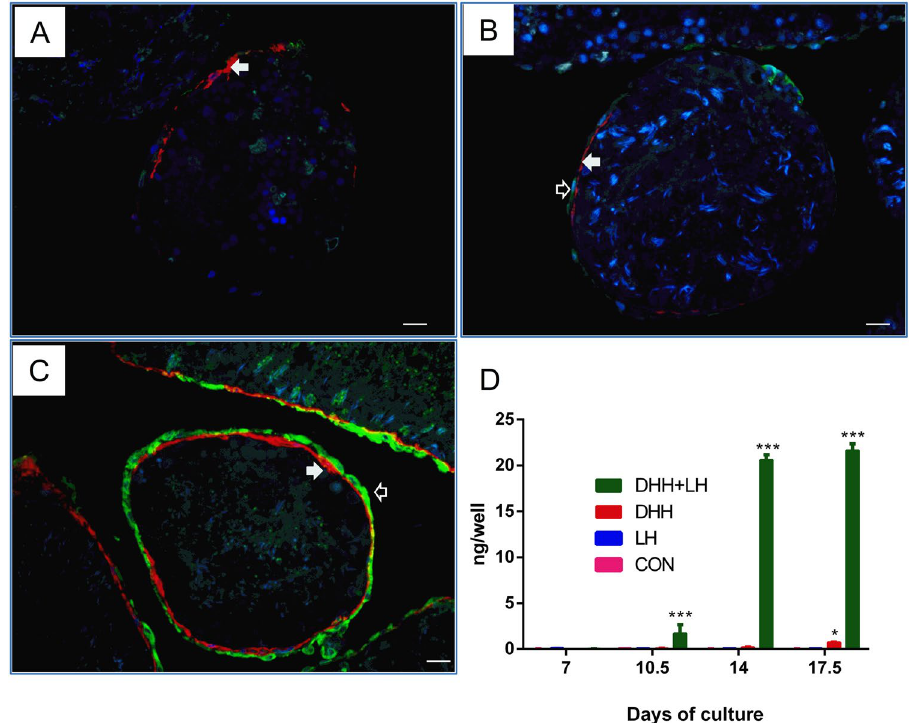
Figure 6. Differentiation of Leydig cells using an in vitro culture system of rat seminiferous tubules. 11 β - HSD1 staining (green color, unfilled arrow) showed the formation of Leydig cells at the advanced stages. α -Smooth muscle actin staining (red color, solid arrow) showed the myoid cells, which circle the seminiferous tubules. 11 β -HSD1 positive cells are outside the α -smooth muscle actin positive cells, indicating that they were differentiated from the stem Leydig cells on the surface of the tubule. Immunohistochemical staining of tubules after 21 days of culture: Panel A, with LH alone; panel B with DHH alone; and panel C with DHH and LH. Medium testosterone (T) levels during the course of culture (panel D). Mean ± SE, n = 6. * P < 0.05, *** P < 0.001 indicate significant differences when compared to control (CON) at each time